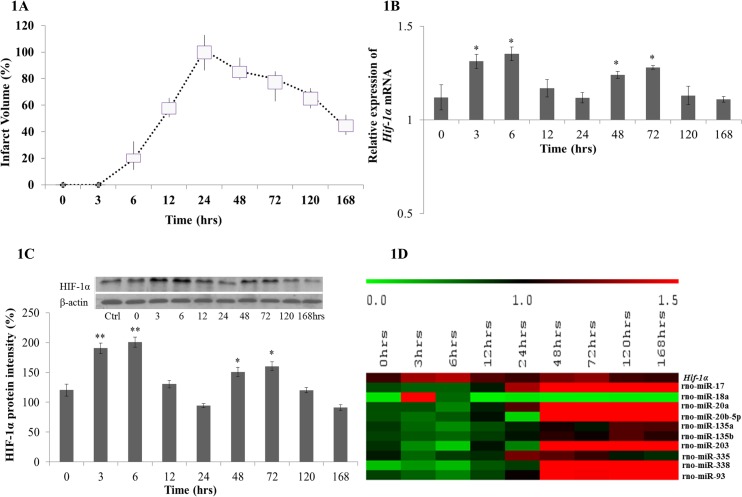
Infarct volume and the expression of HIF-1α mRNA, protein and miRNAs predicted to target Hif-1α at 0, 3, 6, 12, 24, 48, 72, 120 and 168 hrs after eMCAo.(A) Box plot on percentage of infarct volume at each time point after eMCAo. Brain slices were stained with TTC prior to the measurement of the infarct size. Infarct volume at 24 hrs post occlusion reached the maximum (350 ± 30mm3) than that of other time points (p value < 0.05), thus the infarct volume at 24 hrs was set as 100%. (B) Hif-1α mRNA expression at each time point upon cerebral ischemia. Hif-1α mRNA was measured by quantitative RT-PCR and presented as relative expression (mean ± SD with n = 3). (C) HIF-1α protein expression at each time point upon cerebral ischemia. Expression was measured by Western blot and the intensities of the bands were quantified using Image J software and presented as percentage of control (%). (D) Heat map of predicted miRNAs and Hif-1α expression in eMCAo model. miRNA presented as relative expression of miRNAs from the array data. The differentially expressed miRNAs that were statistically significant (one-way ANOVA p value < 0.05) are included. Hif-1α mRNA expression presented as relative expression measured by realtime PCR (mean ± SD with n = 3).